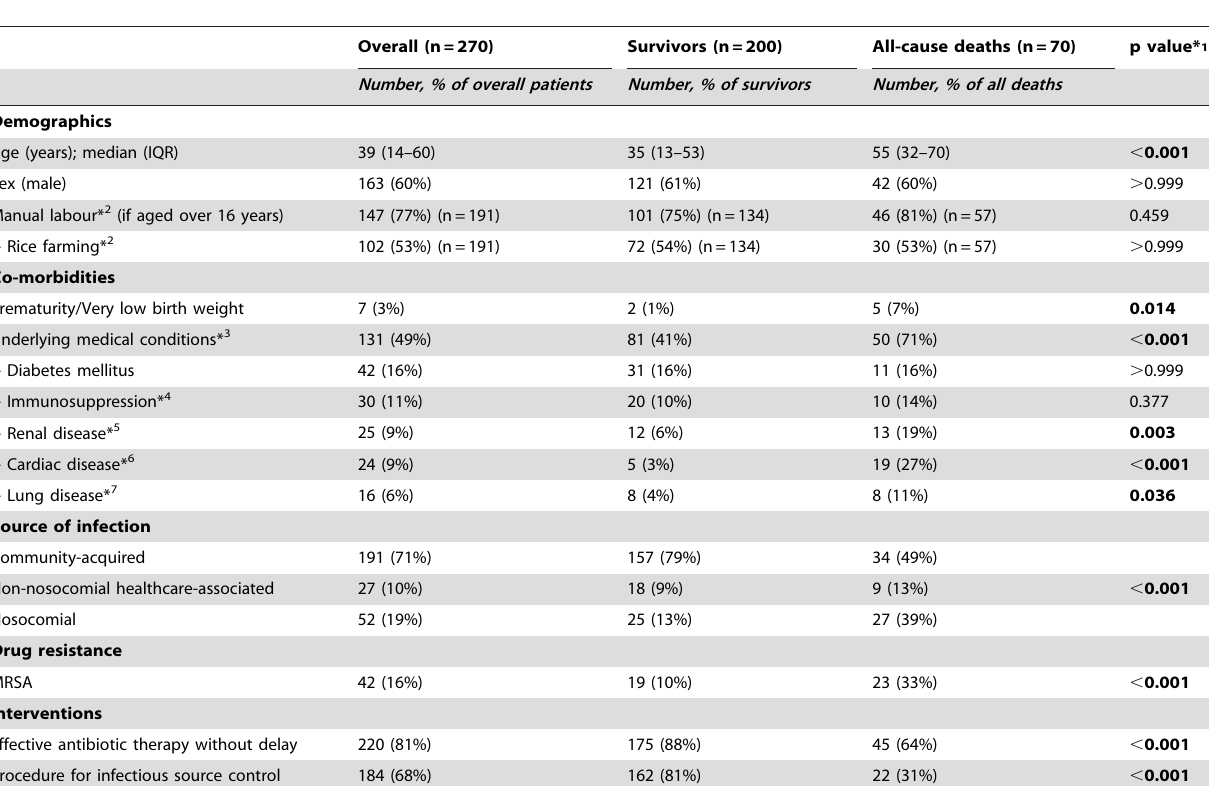
Table 1. Association between patient characteristics and outcome for 270 patients with S. aureus